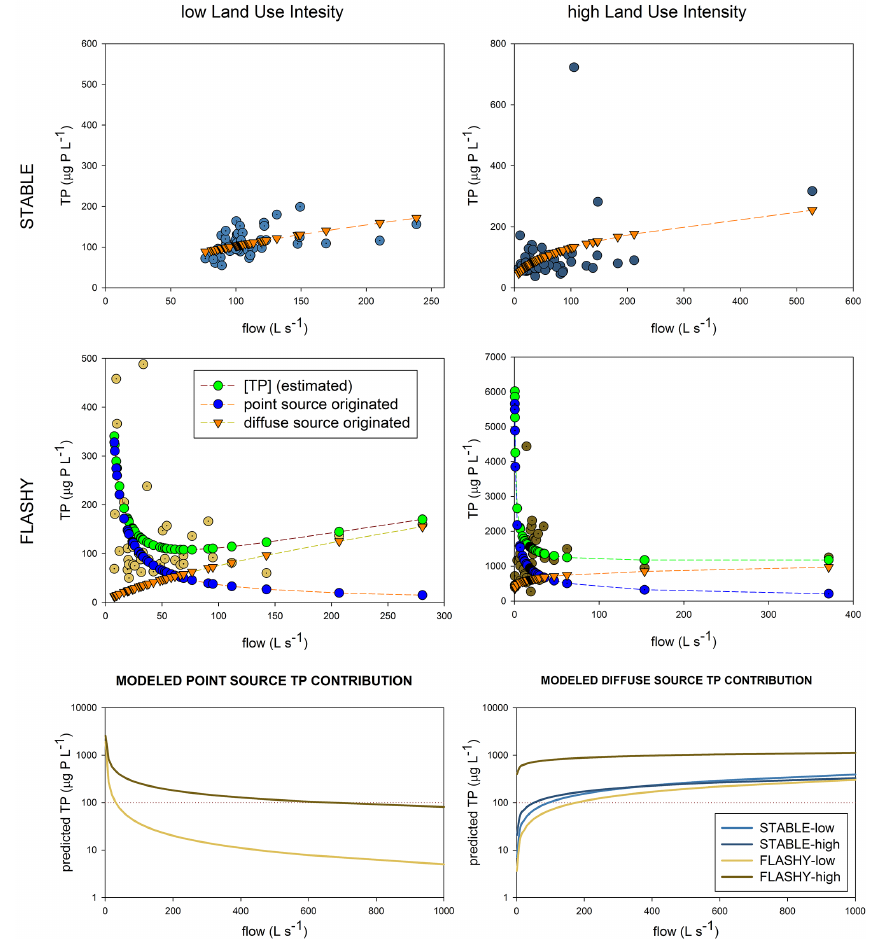
Figure 4. Scatterplots of total phosphorus (TP) concentrations of instantaneous-grab samples relative to discharge from the four streams. The dots connected by lines represent the predicted values according to the load apportionment model (see Table 4). For STABLE catchments, only the diffuse originated term of the model is included. Lowest graphs display the predicted TP concentration of all catchments from point (left panels) and diffuse sources (right panels) for a range of 0 to 1000Ls − 1 . Note the log 10 scale for TP. STABLE: low-flashiness Danish streams; FLASHY: Uruguayan flashy streams; low- and high-LUI: low and high land use intensity.